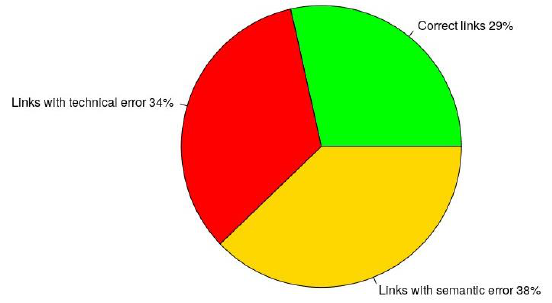
Figure 3. Structure of identical links.